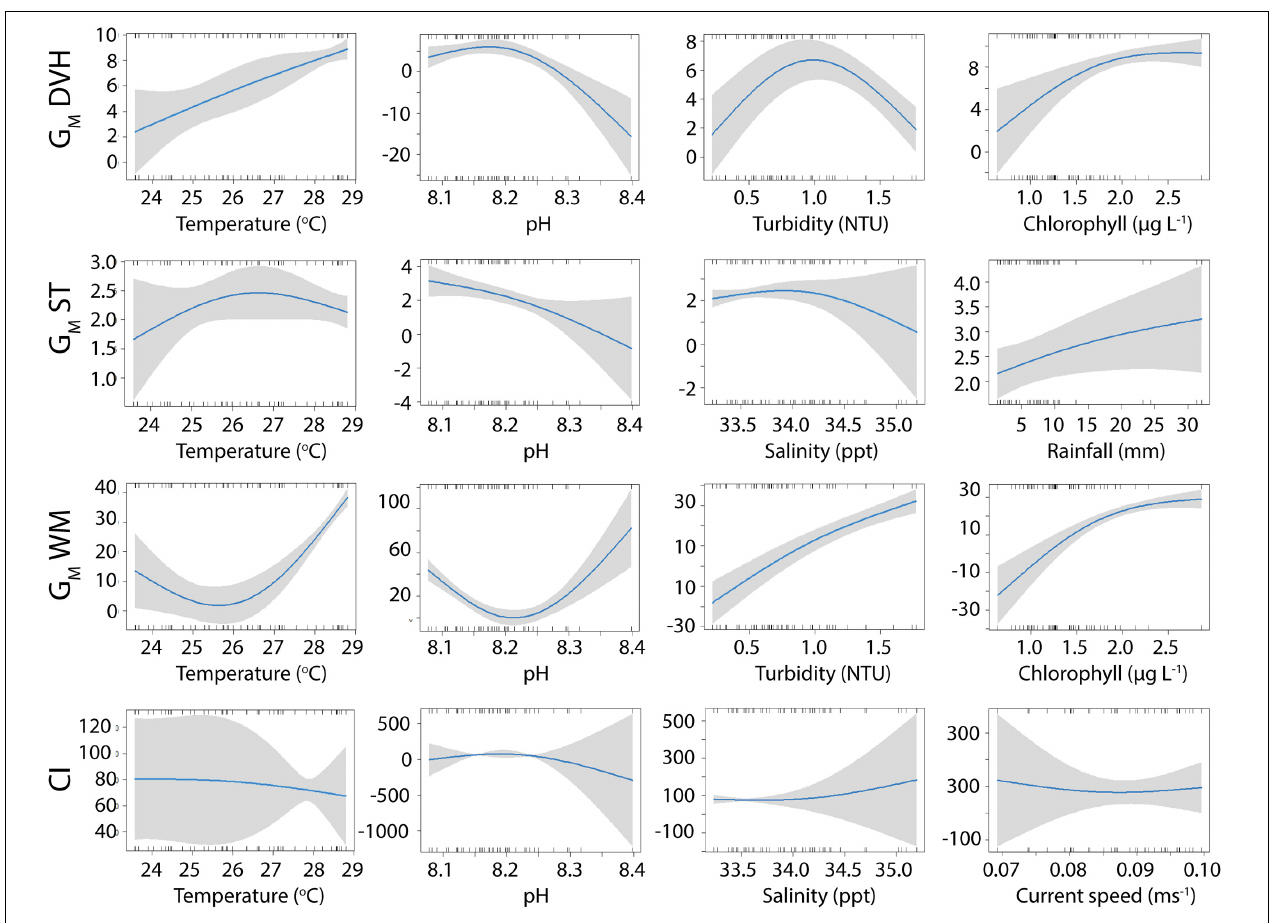
FIGURE 5 | Partial plots from GAMs showing relationships between environmental variables and monthly growth rate (G M ) in dorsoventral height (DVH), shell thickness (ST), wet mass (WM) and condition index (CI) of Pteria penguin . GAMs included variables culture site, age cohort and time and were used to adjust general relationships shown by partial plots. Splines represent GAM model predictions ± 95% confidence